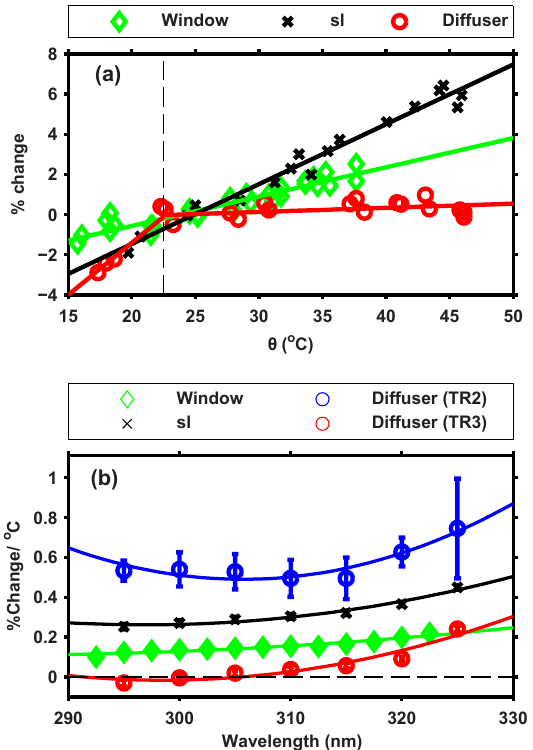
Figure 5. (a) Change in the response of B005 as a function of tem- perature for the SL and measurements through the window and the diffuser, relative to the response at 25 ◦ C and (b) the dependence of the derived slopes from